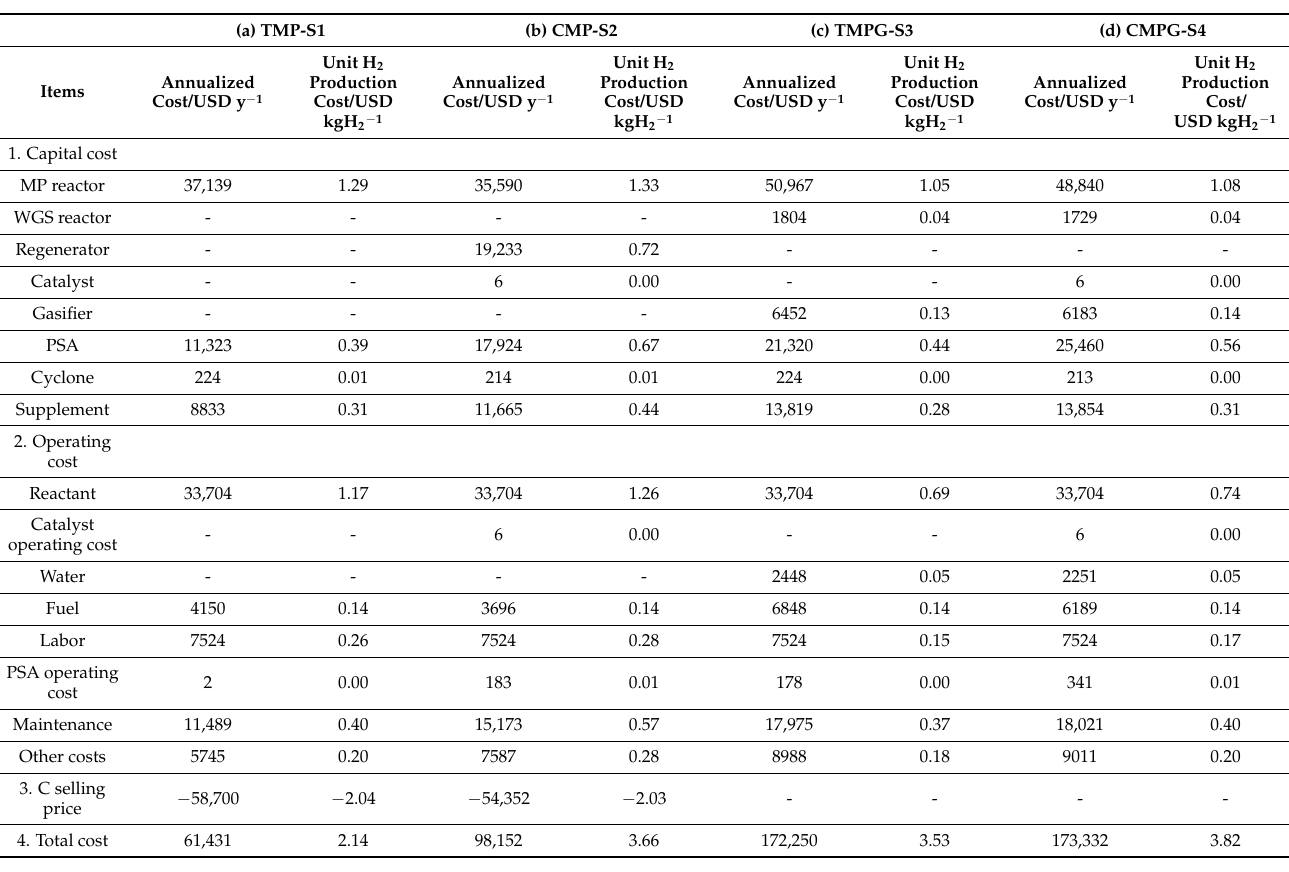
Table 3. Results of itemized cost estimation for methane pyrolysis (MP) systems of ( a ) thermal methane pyrolysis (TMP-S1), ( b ) catalytic methane pyrolysis (CMP-S2), and systems with additional gasification and WGS reaction of ( c ) TMPG-S3 and ( d )